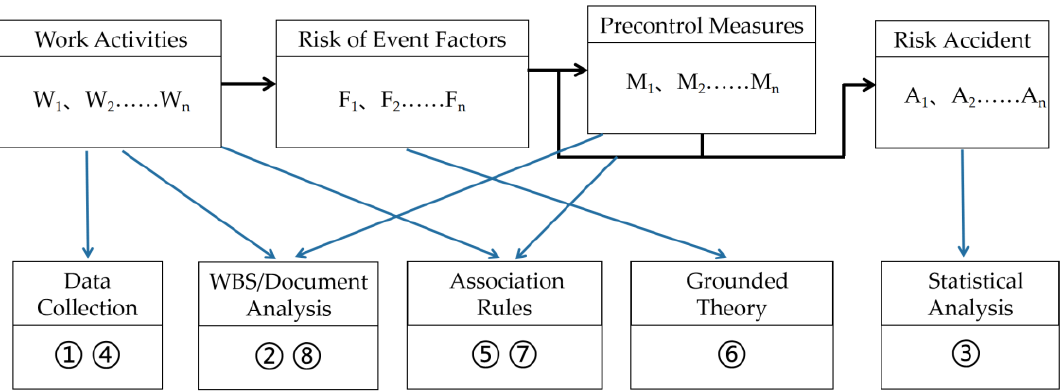
Figure 2. Research paths involved in safety risk